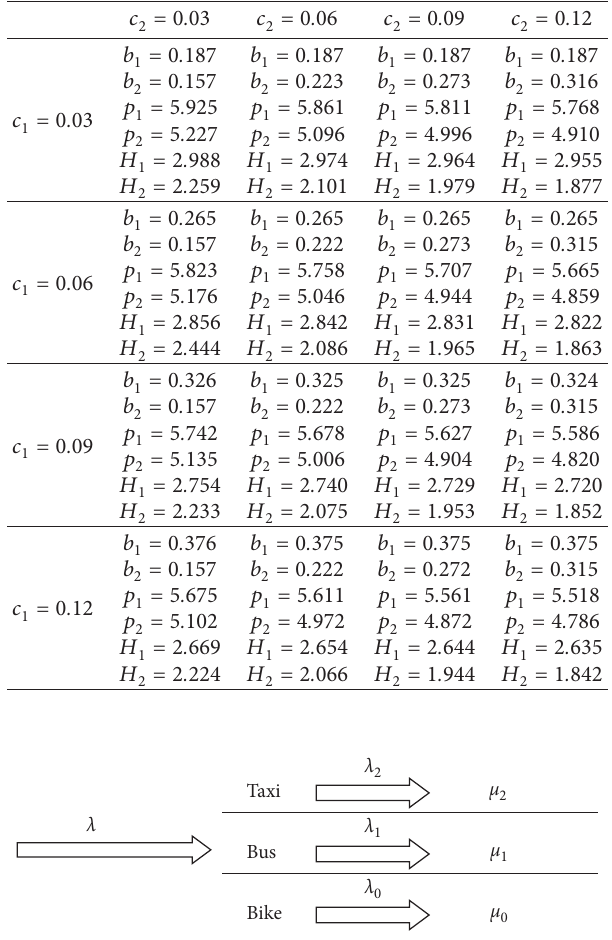
Table 2: Optimal parameters of services in equilibrium.